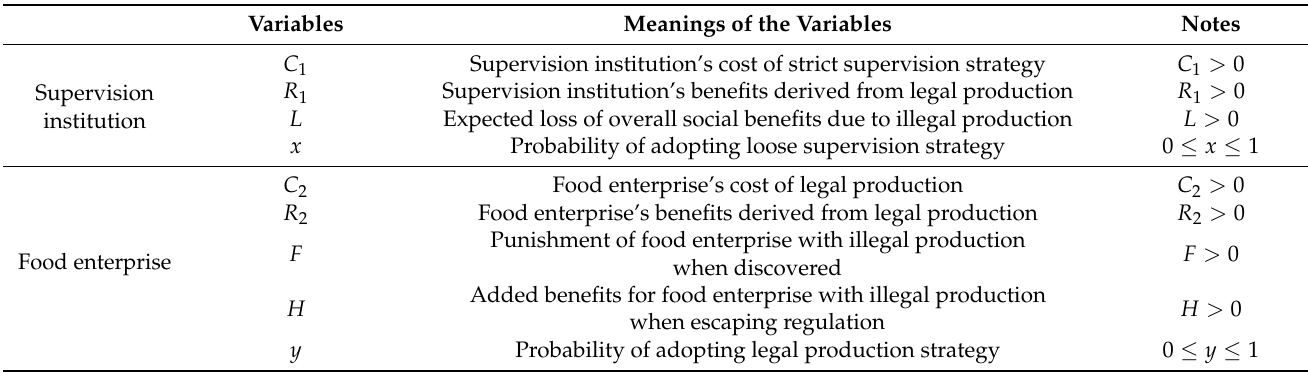
Table 1. Meanings of the variables in the food safety supervision game.